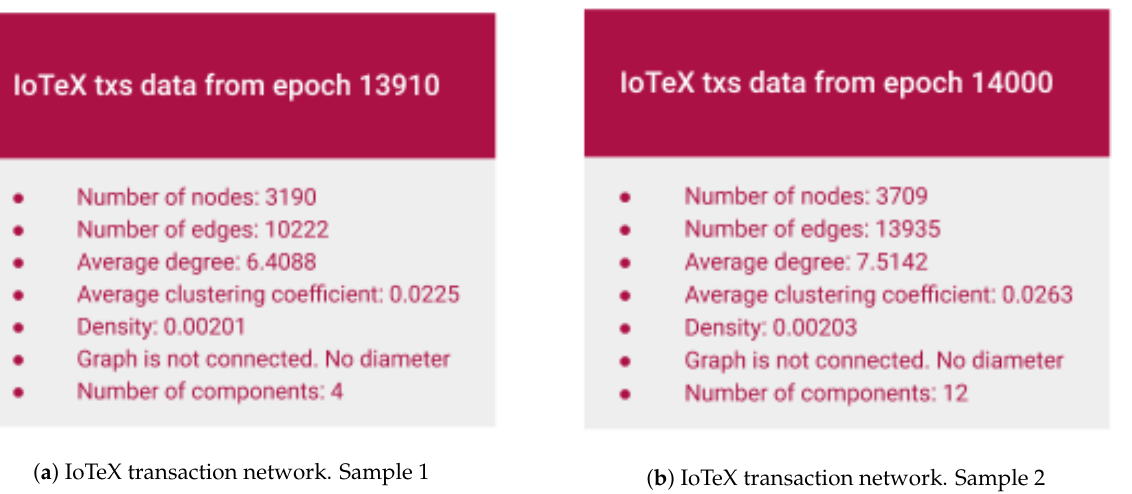
Figure 9. Complex network analysis for IoTeX